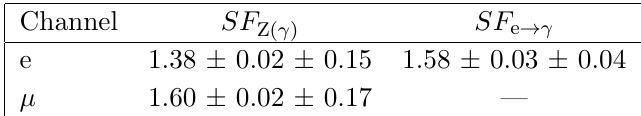
Table 2 . Measured values of scale factors, SF and SF e ! (cid:13) , used to correct the MC predictions Z( (cid:13) ) for Z+jets and Z+ (cid:13) backgrounds and electron-to-photon misidenti(cid:12)cation. For the electron+jets channel, the product of the two is applied to Z+jets and Z+ (cid:13) backgrounds. In the muon+jets channel, only the SF scale factor is relevant. The (cid:12)rst uncertainties are statistical, obtained from Z( (cid:13) ) uncertainties in the resultant (cid:12)ts. The second uncertainties correspond to di(cid:11)erences in the resulting scale factors, added in quadrature, that were obtained by allowing each systematic uncertainty to (cid:13)uctuate up and down by one standard deviation and re(cid:12)tting.